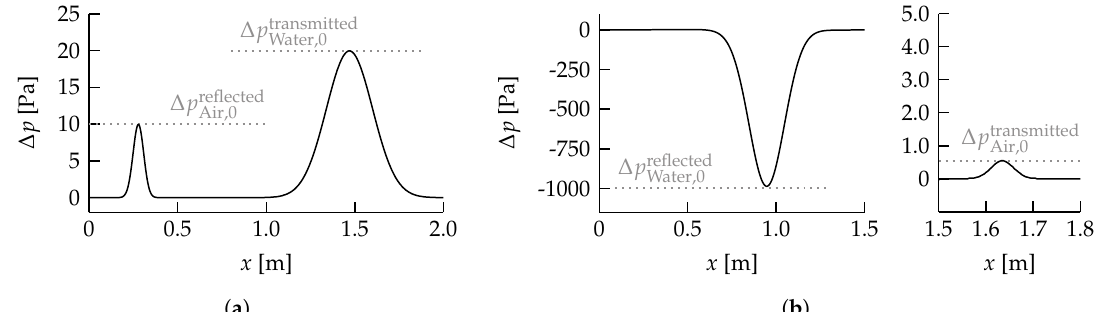
Figure 3. Profiles of pressure pulses in different air–water systems obtained using the proposed algorithm. The amplitudes of the pressure pulses reflected and transmitted at the fluid interface based on linear acoustic theory are shown as a reference. ( a ) Air–water (Water NASG) system